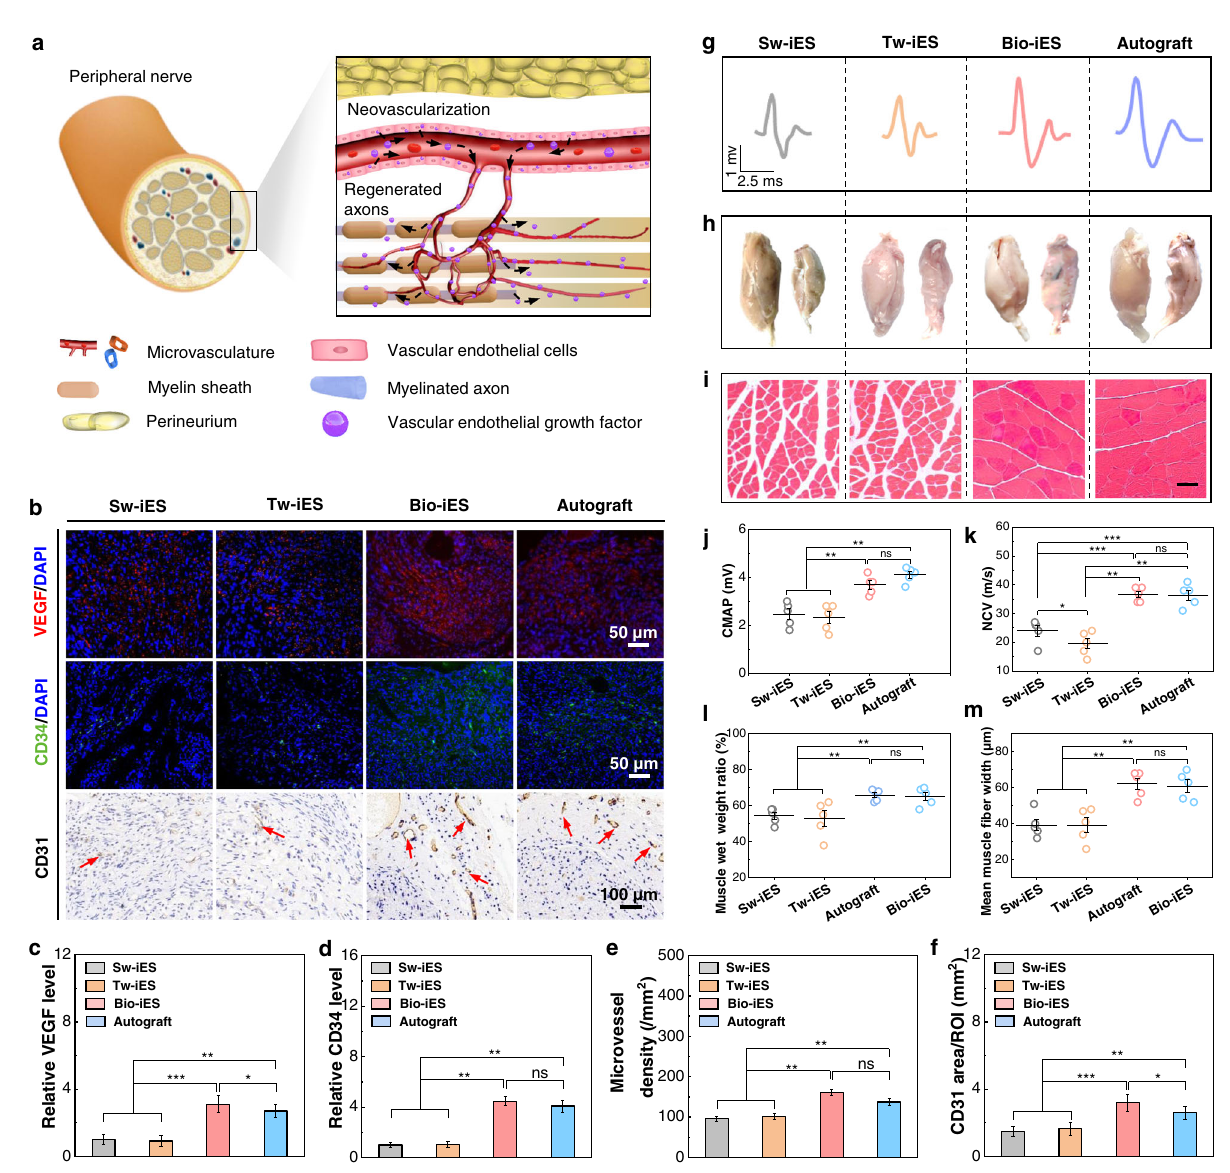
Fig.5|Neovascularizationandneuromotorfunctionalrecoveryofregenerated nerve. a Schematic illustration of vascular endothelial cells releasing vascular endothelial growth factor (VEGF) to induce angiogenesis and neovascularization supporting the axon regeneration of PNI. b Immuno fl uorescent staining images of vascular tissue-speci fi c basic protein: vascular endothelial growth factor (VEGF) (green), hematopoietic transmembrane protein CD34 (red), platelet endothelial cell adhesion molecule CD31 in regenerated nerve, nuclei (blue), red arrows: CD31 cells. c Relative expression of VEGF. d Relative expression of CD34. e MicrovesseldensityintheregeneratednerveswascalculatedfromCD34staining.